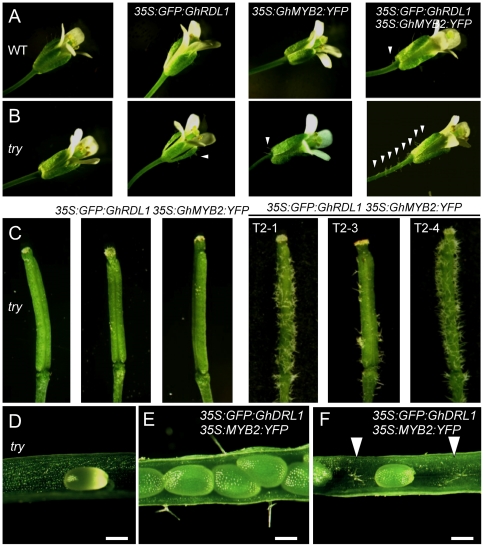
Ectopic trichome production in the transgenic plants overexpressing GhRDL1, GhMYB2, or GhRDL1 and GhMYB2 together.(A) Flowers of A. thaliana Col (WT, left) and transgenic plants overexpressing GhRDL1, GhMYB2, and both (right). (B) Flowers of A. thaliana try mutant (left) and transgenic plants overexpressing GhRDL1, GhMYB2, and both (right). Arrows indicate ectopic trichomes. (C) Ectopic trchomes outside siliques produced in three try transgenic plants (T2-1 to T2-3) overexpressing both GhRDL1 and GhMYB2. (D) No ectopic silique trichome was observed in the try mutant. (E–F) Ectopic trichomes produced outside (E) and inside (F) siliques in the try transgenic plants ovexpressing GhRDL1 and GhMYB2. Scale bars (D–F) represent 300 µm.